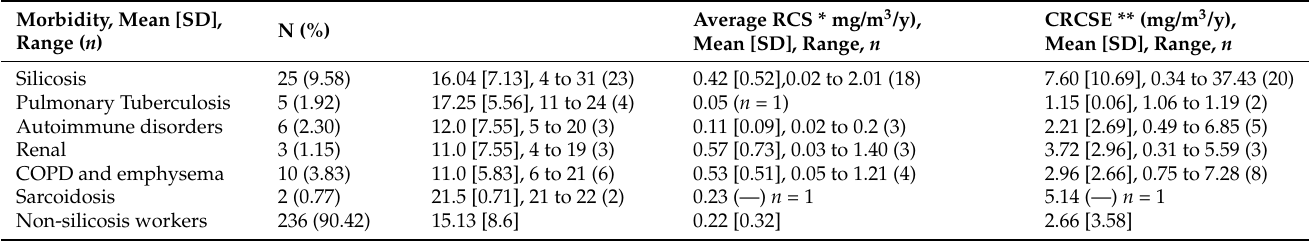
Table 3. Morbidity and total silica exposure for each disease of interest.